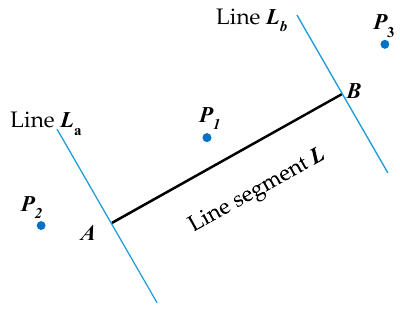
Figure 6. The distance between points and line segment L .